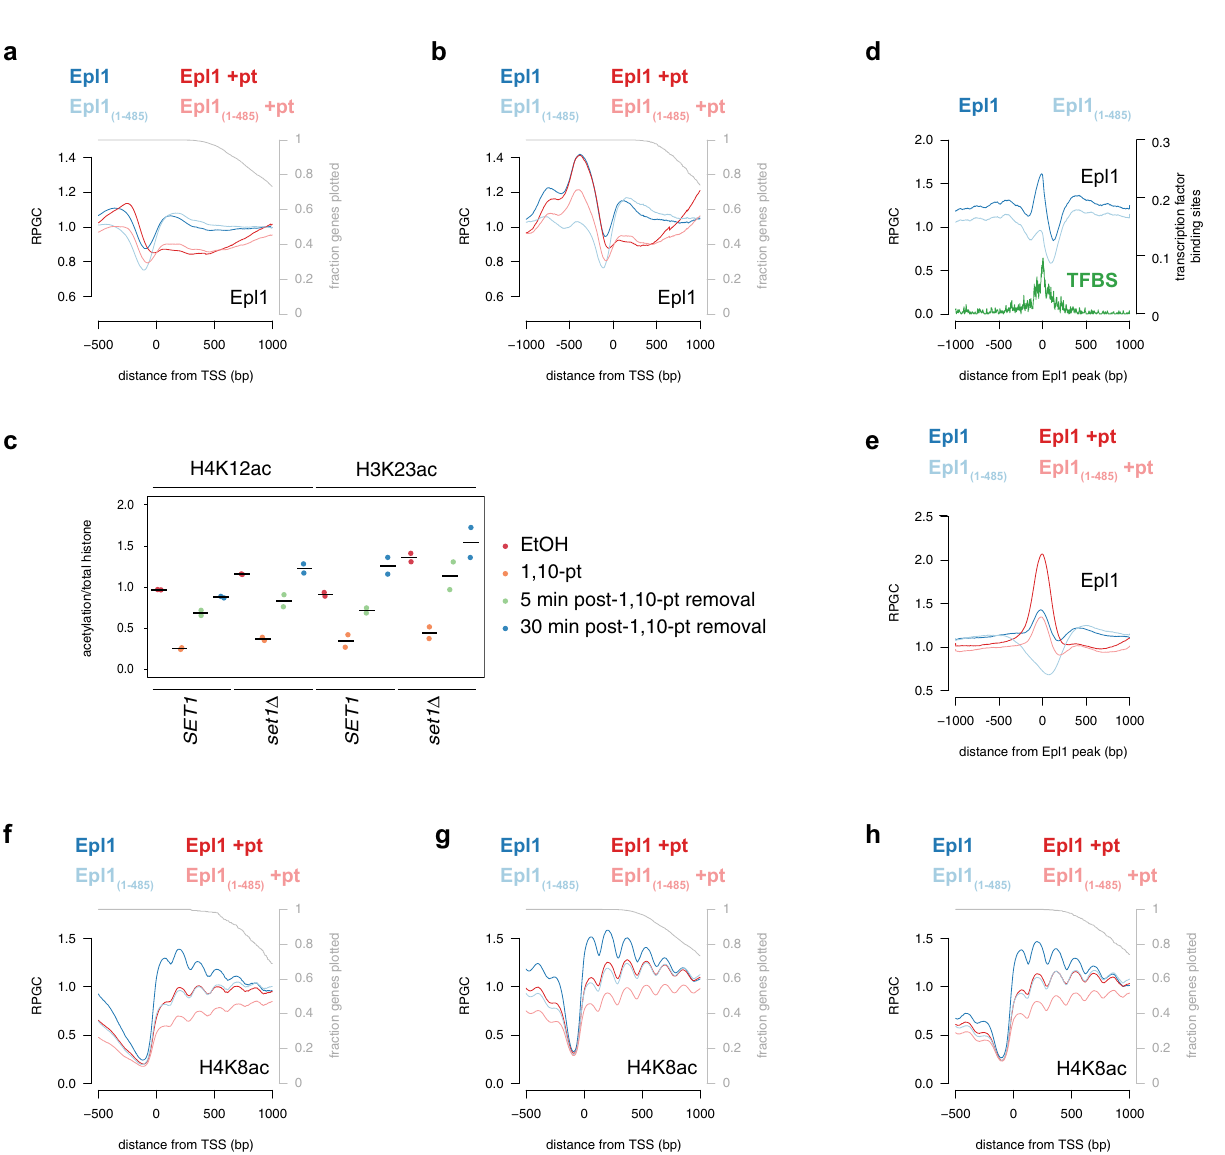
Fig. 2 Transcription promotes the interaction of H4-speci fi c HATs with chromatin. a , b Average pro fi le of Epl1 (dark lines) or Epl1 1 – 485 (light lines) ChIP- seq from sonicated extracts at all genes (5206) ( a ) or 832 unidirectional promoter genes ( b ) aligned by the TSS before (blue) and after (red) a 15-min treatment with 1,10-pt. Only data until the PAS was included, and the gray line represents the fraction of genes plotted for each position. Data from drug- treated and mutant cells were normalized to untreated wild-type (see “ Methods ” ). RPGC reads per genomic coverage, TSS transcription start site. c Strip plots of histone acetylation immunoblot signals normalized to histone H4 levels from two independent yeast whole-cell extracts. Wild type and set1 Δ cells were either untreated (red) or treated with 1,10-pt for 30 m, followed by TSA treatment for an additional 30 m (orange), before being washed into fresh media containing TSA. Samples were collected 5 (green) and 30 (blue) minutes post wash. Horizontal lines indicate the mean. d Average pro fi le of Epl1 (dark blue) and Epl1 1 – 485 (light blue) ChIP-seq from MNase-treated chromatin relative to the center of 562 regions showing strong Epl1 peaks (peak coordinates are provided in the Source Data fi le). The abundance of transcription factor binding sites (TFBS) 38 across the region is shown in green. e Average pro fi le of Epl1 (dark lines) and Epl1 1 – 485 (light lines) ChIP-seq from sonicated extracts from cells before (blue) and after (red) a 15-min treatment with 1,10-pt, relative to the center of 562 regions showing strong Epl1 peaks. f – h Average pro fi les of H4K8ac ChIP-seq from MNase-digested extracts from Epl1 (dark lines) and Epl1 1 – 485 (light lines)-expressing strains, before (blue) and after (red) a 15-min treatment with 1,10-pt, at genes with strong Epl1 peaks ( f ), all genes ( g ), or 832 genes with promoters lacking divergent transcription ( h